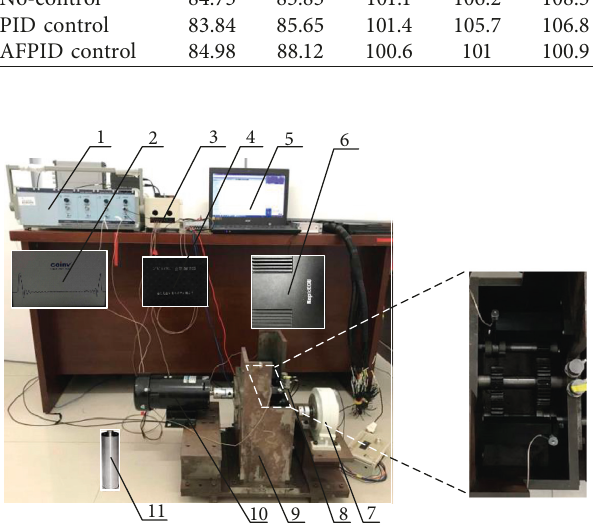
Figure 14: Gear system vibration active control test platform. (1) Power amplifier. (2) Signal collector. (3) Motor governor. (4) Signal conditioner. (5) Computer. (6) Real-time simulation system. (7) Magnetic powder brake. (8) Vibration acceleration sensor. (9) Gearbox. (10) Drive motor. (11) Piezoelectric actuator.